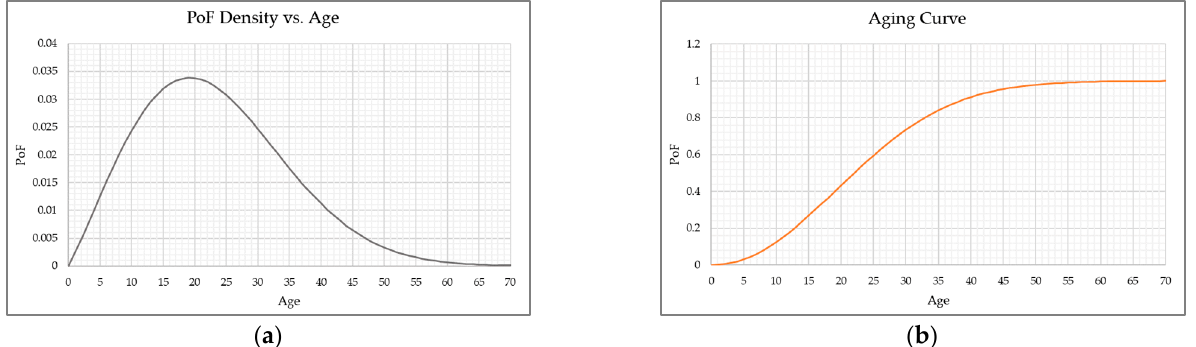
Figure 5. Weibull distribution approaching aging curve analysis: ( a ) failure probability density versus age; ( b ) aging curve.